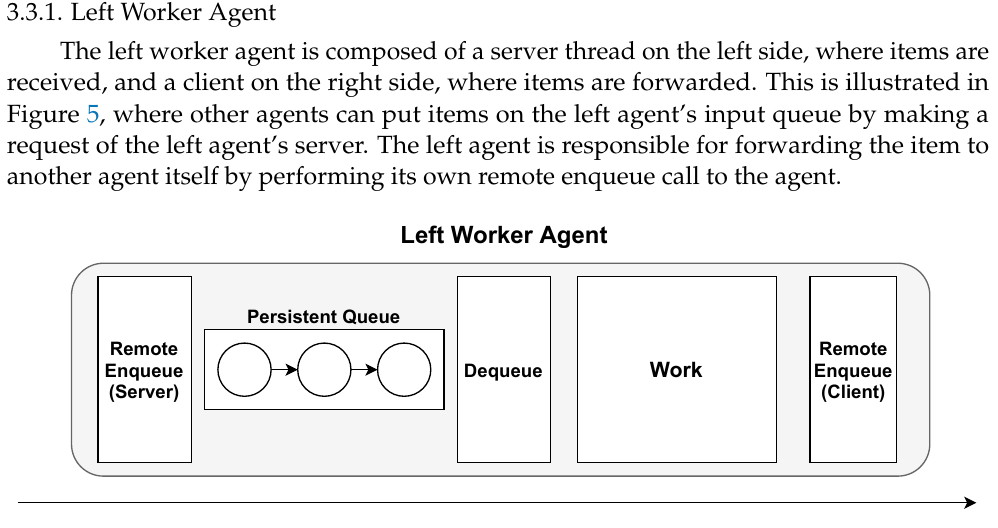
Figure 5. Left worker agent. A worker agent that dequeues messages from a local queue before the analysis process, but enqueues the result